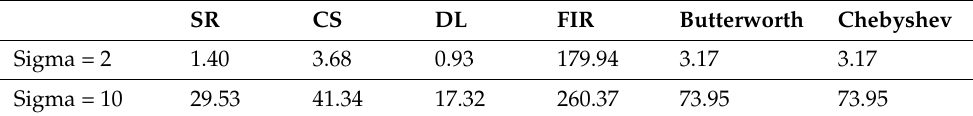
Table 4. Comparison of MSE.